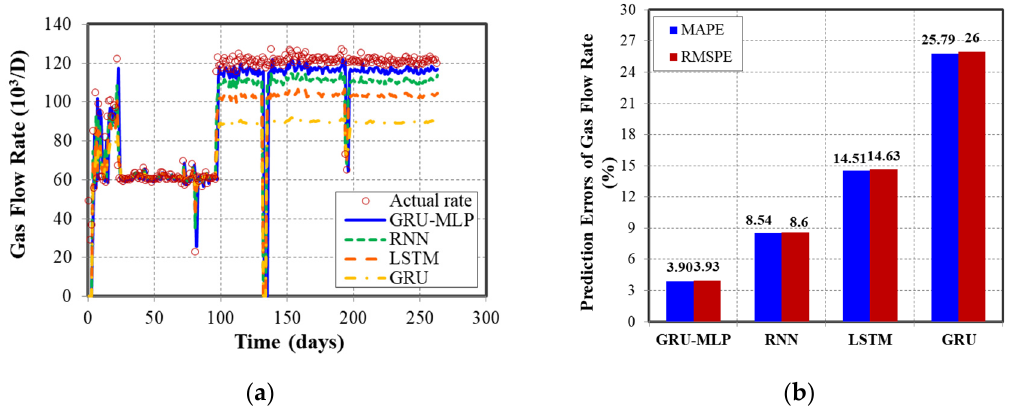
Figure 12. Comparisons of four neural network models: ( a ) daily gas production prediction; ( b ) prediction errors.